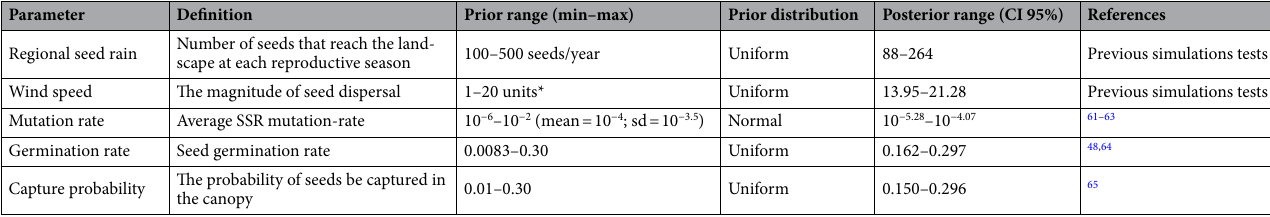
Table 1. TRec model parameters of Tillandsia recurvata populations. Prior ranges are based on literature or previous simulation tests, while posterior ranges are based on the ABC framework. *Each wind speed unit is multiplied by five to refer to the amount of ‘landscape patches’ in the model the seeds can fly freely at each time step of the model.